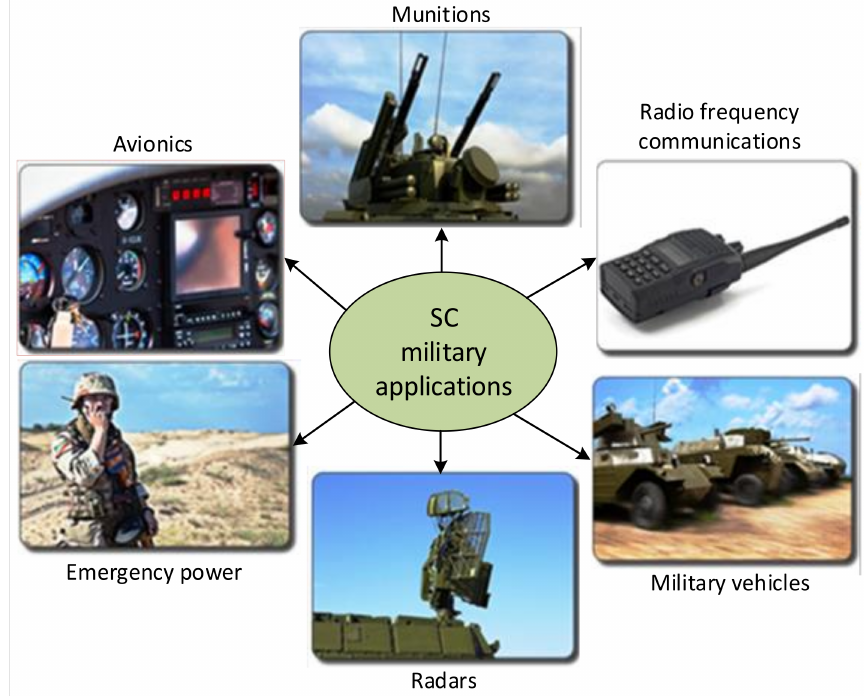
Figure 9. SCs used for different defence